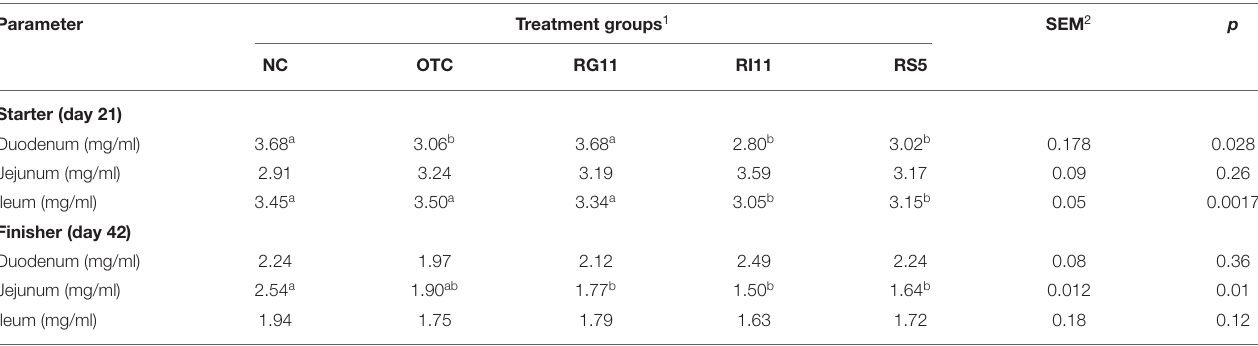
TABLE 7 | Malondialchehyche concentration of chickens when fed different postbiotics.